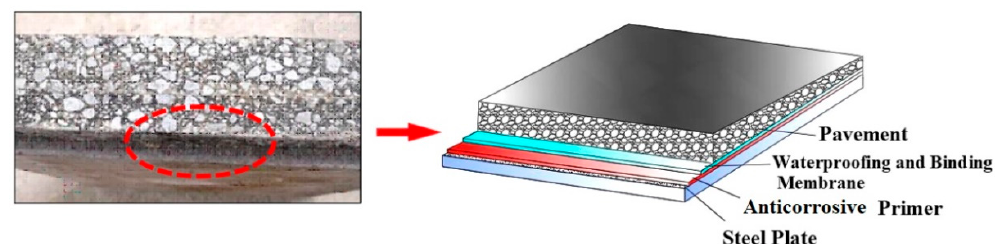
Figure 1. Steel deck pavement composite structure.